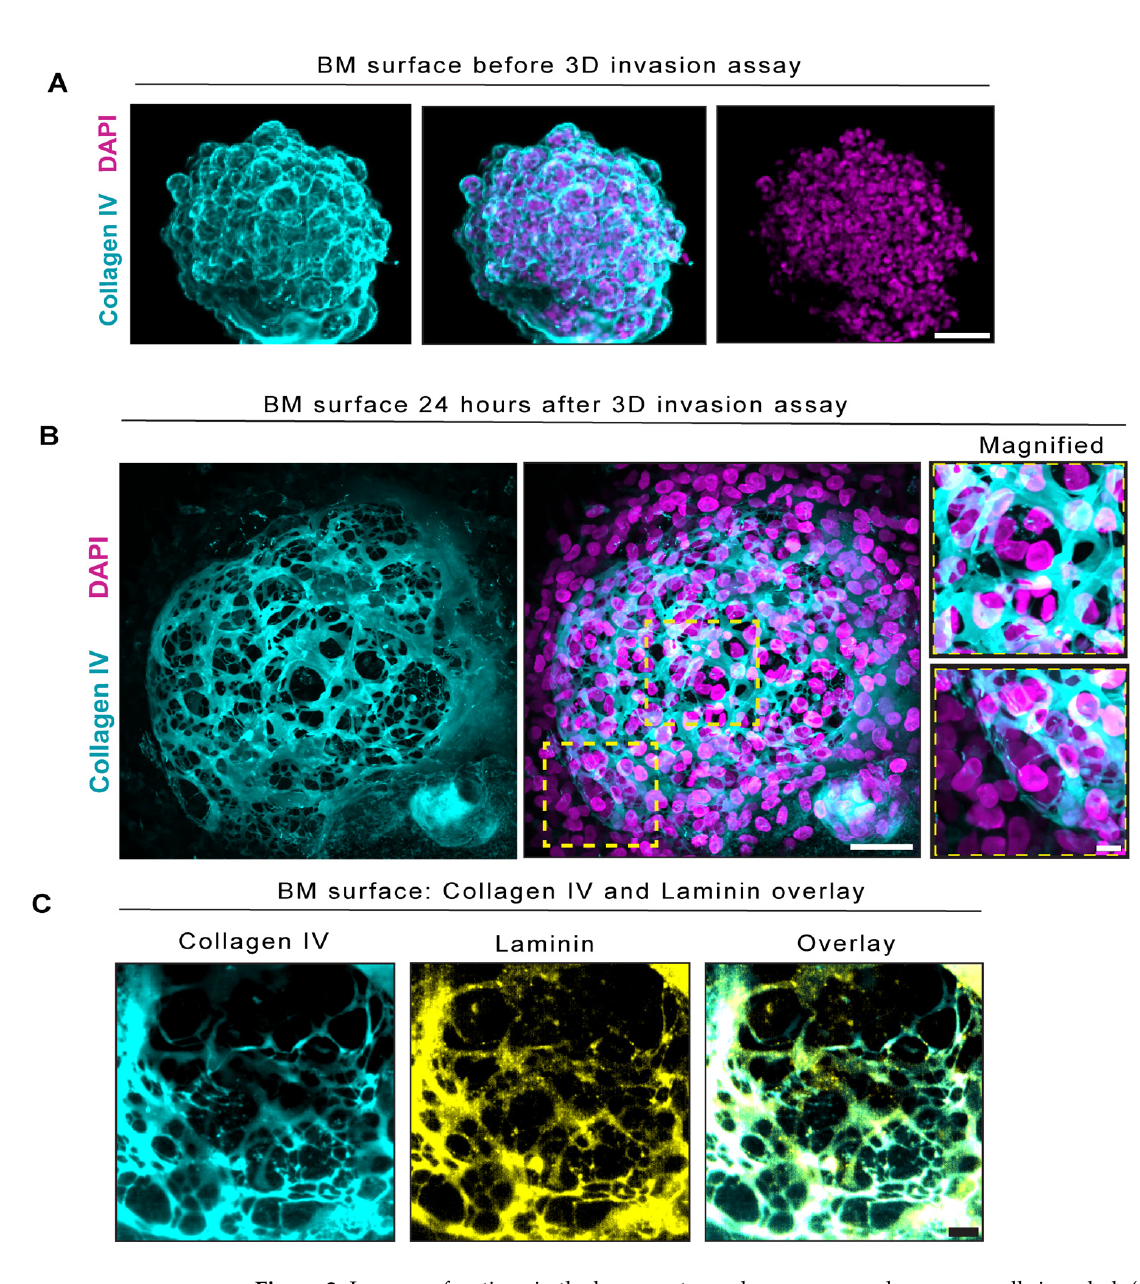
Figure 2. Large perforations in the basement membrane appeared as cancer cells invaded. ( A ) Images show a spheroid with a basement membrane visualized by immunostaining for anti-collagen IV antibody and DAPI (staining for nuclei) before it was embedded in collagen gel. We observed no apparent holes in the basement membrane before the invasion assay. ( B ) 24 h after the spheroids were embedded in collagen gels, large holes were visible with collagen IV immunostaining (cyan) of the basement membrane (upper inset). DAPI staining denoting cell nuclei (magenta) demonstrated many cells outside of the basement membrane (lower inset). ( C ) Immunolocalization of collagen IV (cyan) and laminin (yellow) staining in the in vitro basement membrane. These figures are representatives of at least 3 independent experiments, each including at least 3 spheroids per experiment, all of which showed similar results. Scale bars: ( A , B ), 100 µ m; Inset of ( B , C ), 10 µ